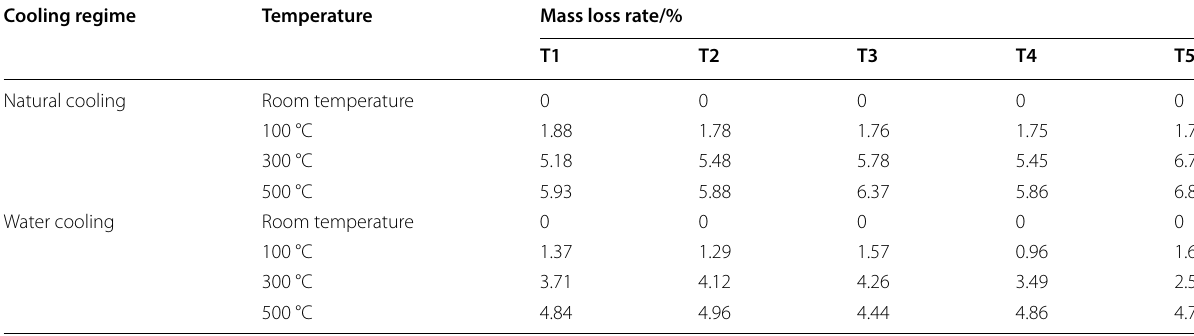
Table 3 Mass loss rate of concrete produced with desert sand after elevated temperature.